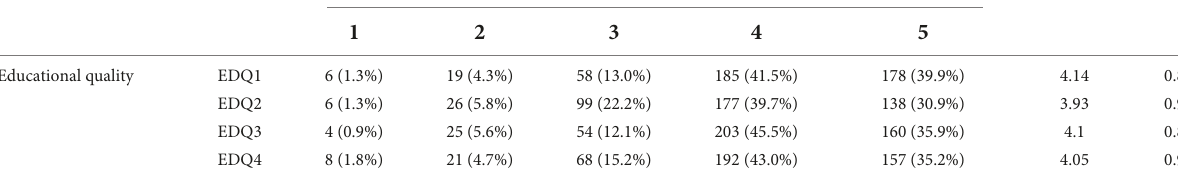
TABLE 7 Measuring social influence (SOI).